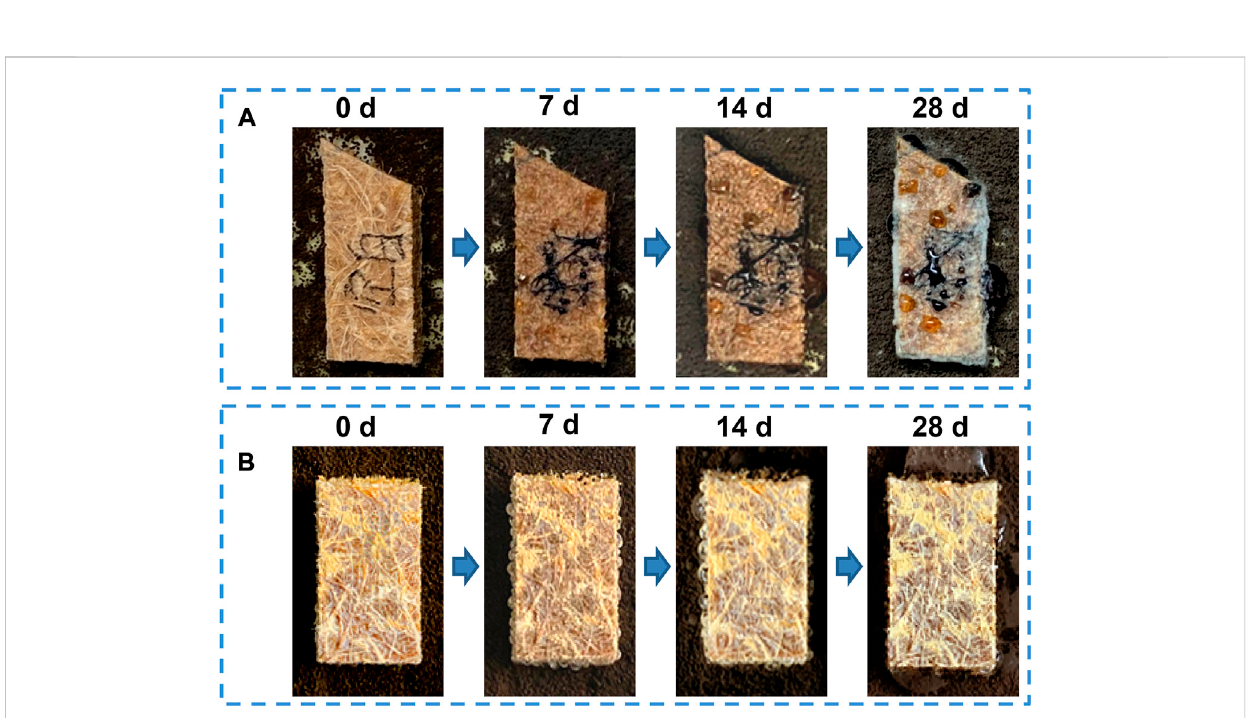
powder on the modi fi ed BPC was rapidly removed by water, and no powder residue was observed after being rinsed, as shown in Figure 6B. The above phenomena show the self-cleaning behavior of BPC-TiO 2 -F. The combined Wenzel-Cassie model (Marmur, 2004; Ma et al., 2012; Peng et al., 2022) (Figure 5D) is a reasonable explanation for the self-cleaning property. The surface with a micro/nano-hierarchical roughness and low surface energy